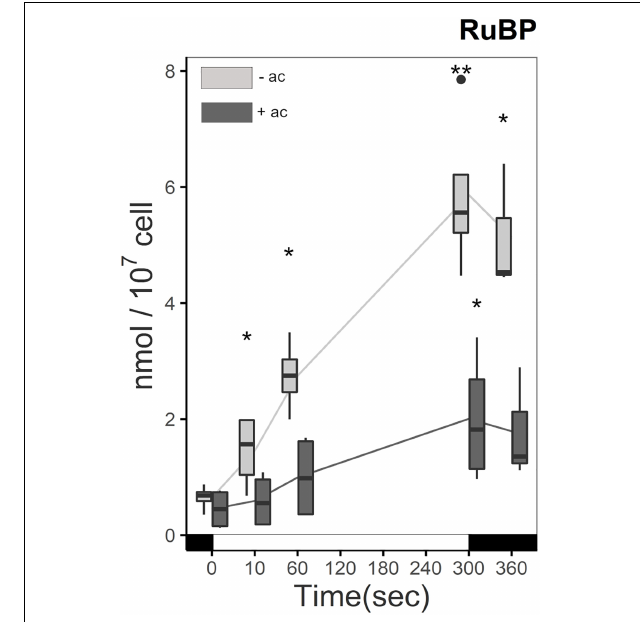
FIGURE 4 | Increase in RuBP quantity in (cid:49) rbcL under illumination with (dark gray) and without (light gray) acetate. Cells were irradiated with 300 µ mol photons m − 2 s − 1 (white segment) and samples were taken at different time points (as described in Figure 2 ). Metabolites were quantified per LC-MS/MS after quenching and extraction. Light significantly affected the accumulation of RuBP ( p -value < 0.001), and there was a significant difference due to acetate ( p -value < 0.001). Pairwise t -test were performed between time points (one asterisk, p < 0.05; two asterisks, p < 0.01). The boxplot has been built with four replicates. The line represents the mean. The dots represent outlier data that has been taken into account for standard error and statistics, designated as a dot in the whisker